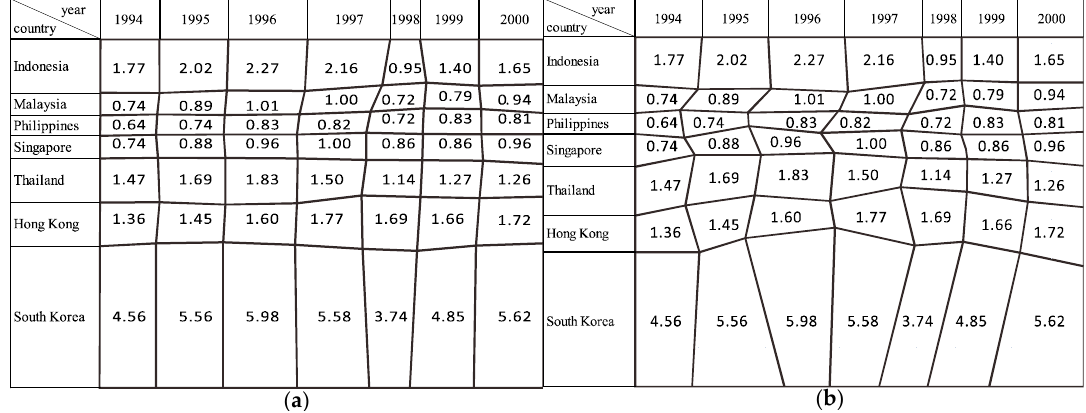
Figure 4. Quadrilateral table cartograms of Gross Domestic Product( GDP) (10 billion current USD) of Eastern and Southeastern Asian countries before and after the Asian financial crisis in late 1990s: ( a ) Proposed method; ( b ) Previous method in [8]. Table 2. Comparison of data representation precision and deformation by the proposed method and the method in [8].